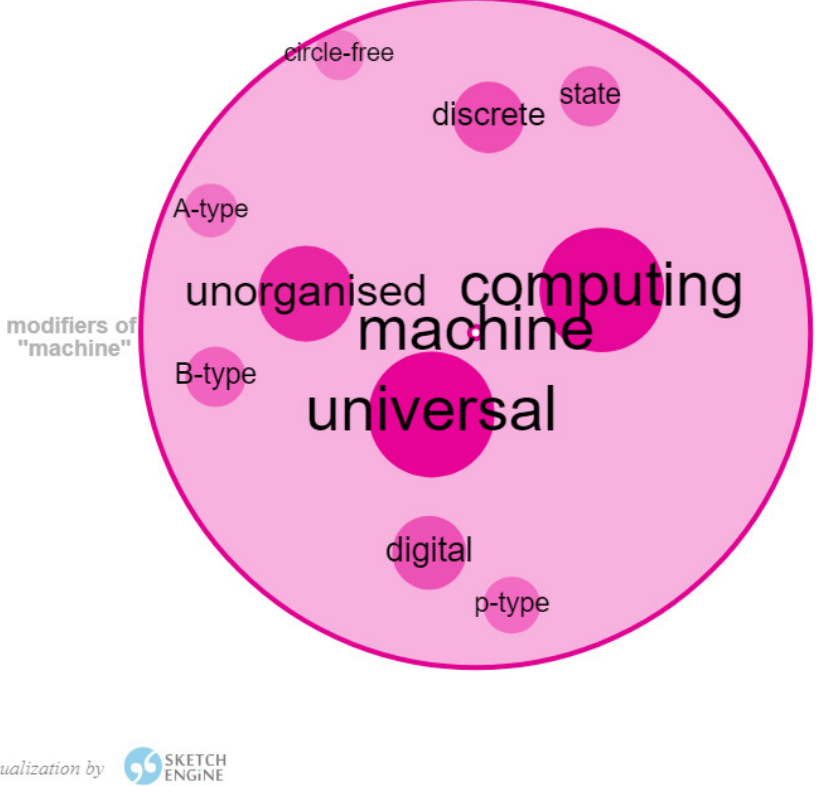
Figure 5. Modifiers of the term “machine” in the Turing corpus. To create this diagram in SketchEngine, click “Word sketch”, enter the term “machine” and click GO, and then select the column showing modifiers of “machine” by clicking the icon “Only keep this column . . . ”. Next, click Show Visualization on the top right-hand side. The circle sizes reflect frequency, while distance reflects the collocation strength.